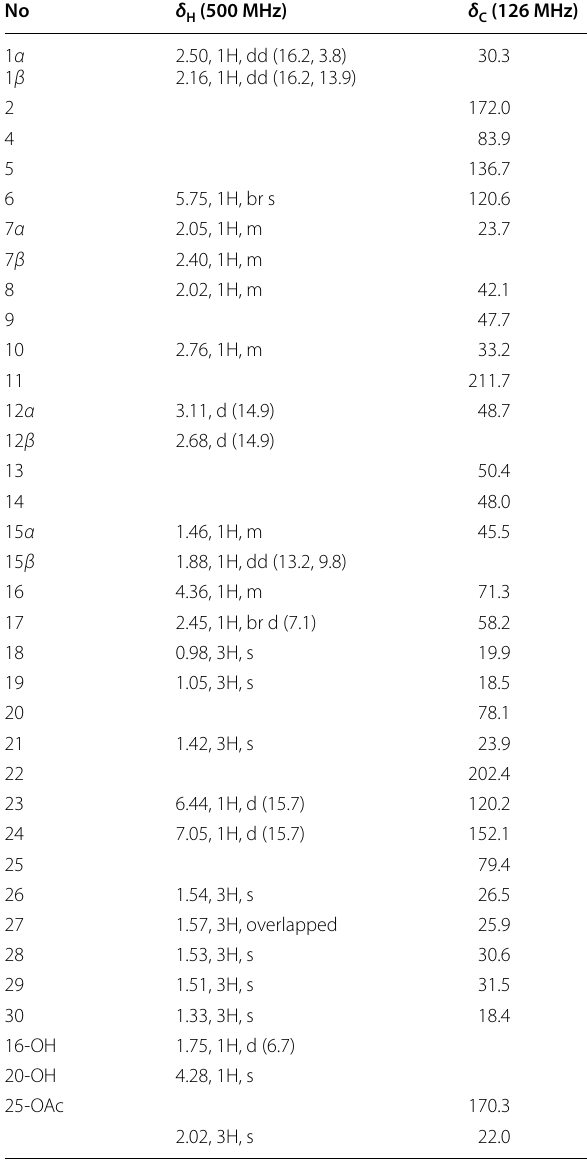
Table 6 1 H and 13 C NMR data of compound 1 in CDCl ppm, J in